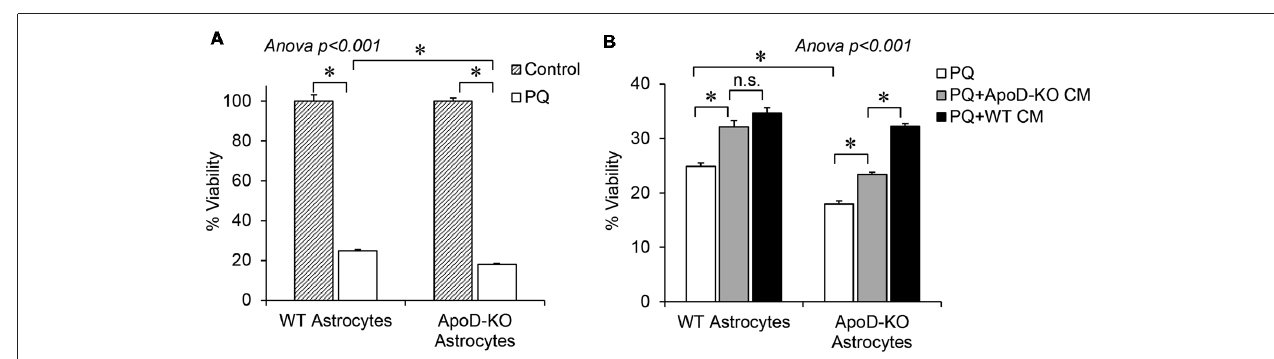
FIGURE 7 | Extracellular ApoD mediates autocrine protection of primary murine astrocytes. (A) Percent viability estimated by the MTT assay of WT and ApoD-KO primary astrocytes cultured in SM, in either control or upon an OS challenge with PQ (500 µ M, 2 h). ApoD-KO astrocytes are significantly more vulnerable to PQ than WT astrocytes. (B) PQ challenge was performed either on SM (white bars), or in astrocyte-CM, either derived from ApoD-KO astrocytes (gray bars) or from WT astrocytes (black bars). Effect of CM on ApoD-KO astrocyte viability is dependent on the genotype of CM origin. Error bars represent SEM ( n = 3 independent experiments with three technical replicas each). Asterisks point to significant differences ( p < 0.01) assessed by ANOVA with Holm-Sidak post hoc method (n.s.: non-significant differences). Only the most relevant comparisons are pointed.